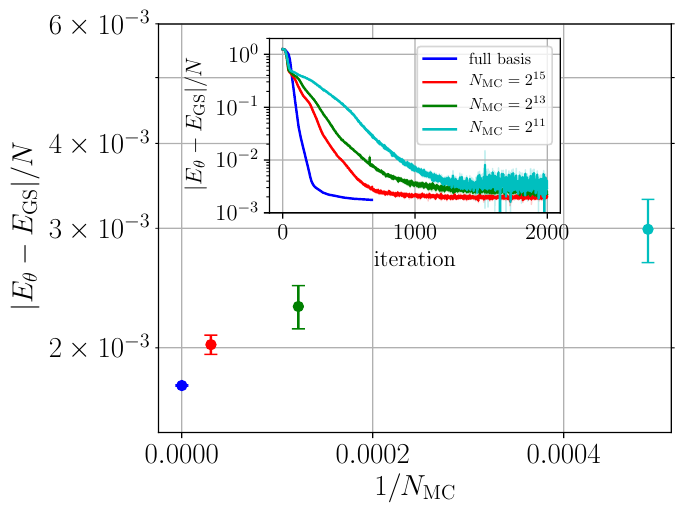
Figure 9: Lowest variational energy density reached, and its MC error bar versus the inverse size of the MC sample 1 / N : increasing the sample size does not necessarily MC lead to a lower energy. Inset: variational energy density against the iteration num- ber for different sample sizes; see inset legend for the values of N . The system MC / J = 0.5. size is N = 6 × 6. The network architecture is listed in App. H, and J 2 1 Optimization was done using RK in combination with SR, see App.